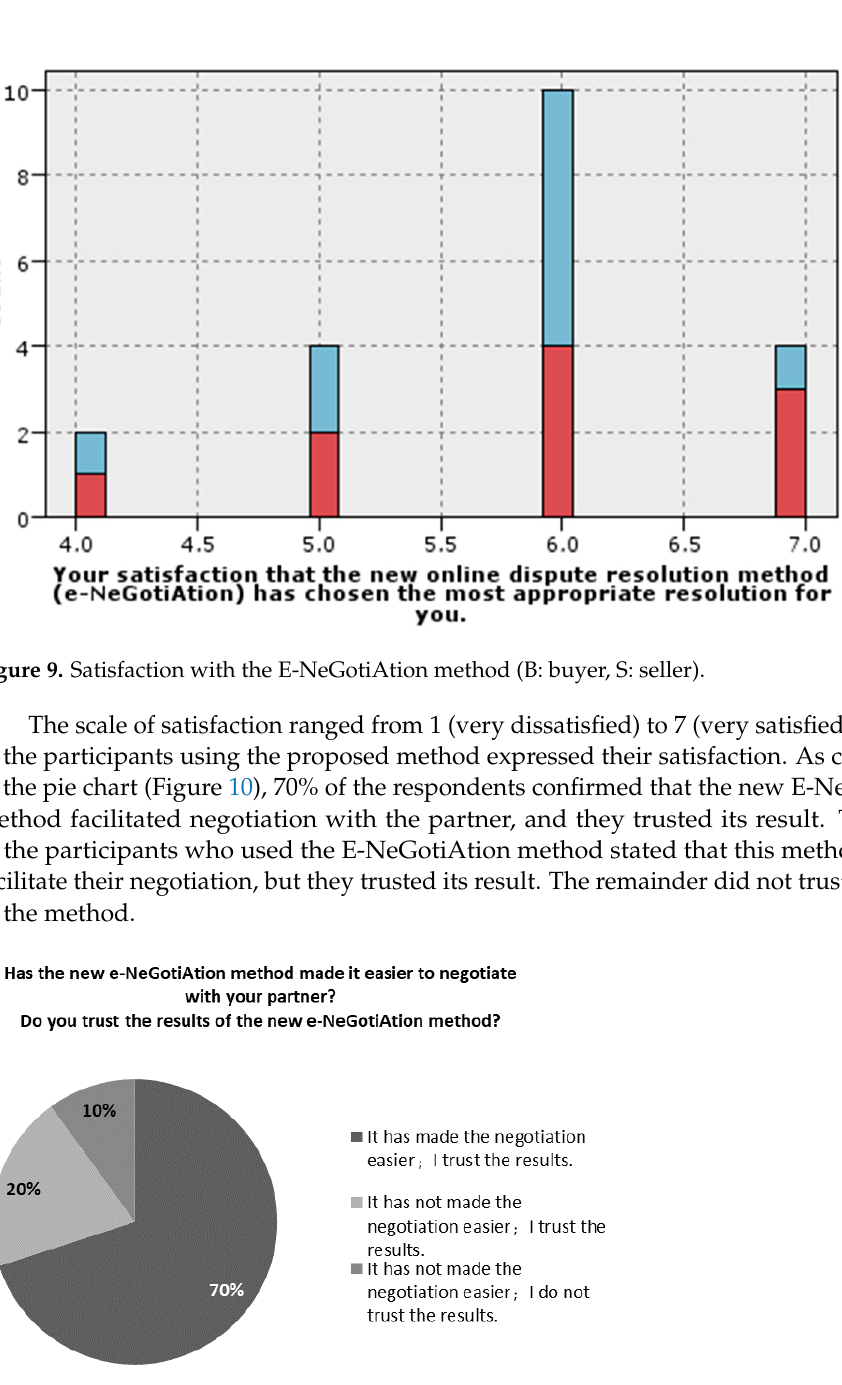
Figure 10. Assessing the method in terms of facilitating negotiation and trust. In open questions, respondents using the E-NeGotiAtion method had to evaluate its positives and negatives. A summary of the advantages is given in the Table 7. Participants positively assessed the objectivity of the method, the transparency of the application, time, and money savings. Table 7. Advantages of the E ‐ NeGotiAtion method. The Advantages of the New E ‐ NeGotiAtion Method Compared with the Partners Reaching the Overall Solution to the Dispute